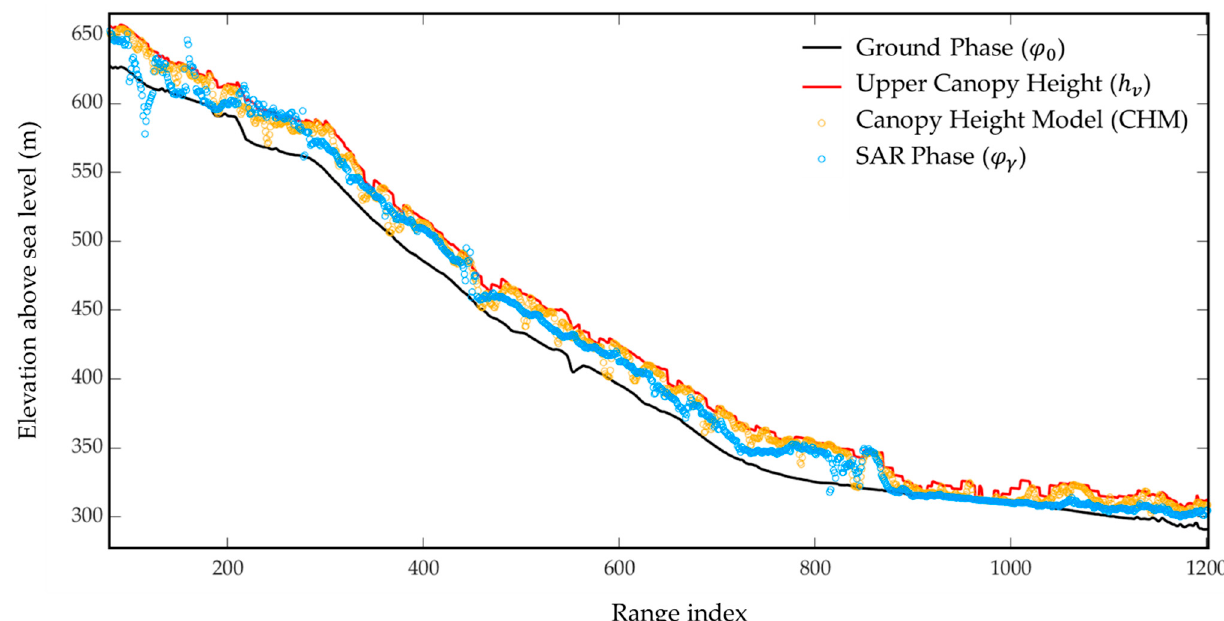
Figure 2. A view of ground phase ( 𝜑 (cid:2868) ) estimated from ALS data against TanDEM-X SAR phase ( 𝜑 (cid:3082)(cid:3557) ). A transect has been considered as an example in elevation scale. 𝜑 (cid:2868) is represented by the black line and 𝜑 (cid:3082)(cid:3557) is represented by the blue circles. Additionally, the canopy height model (CHM) and upper canopy height ( ℎ (cid:3049) ) were included in the transect by orange circles and red line, respectively.